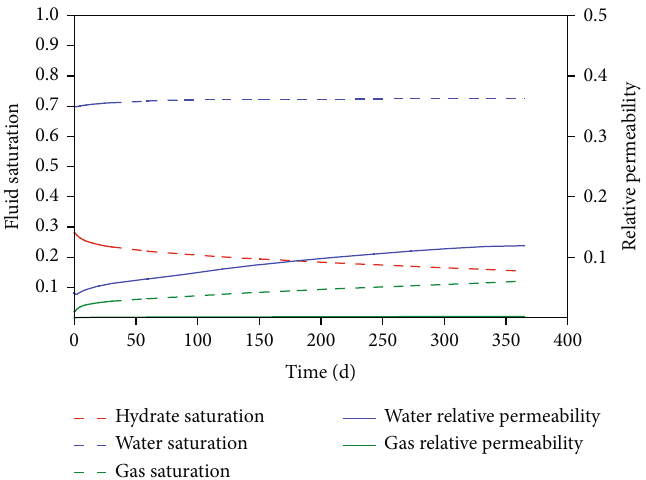
Figure 18: The variations of the water and gas relative permeability 10m from the well.